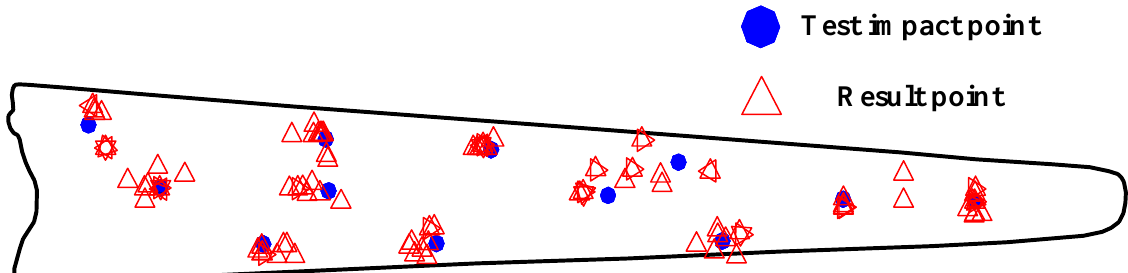
Figure 10. Results of the impact location determination experiment.